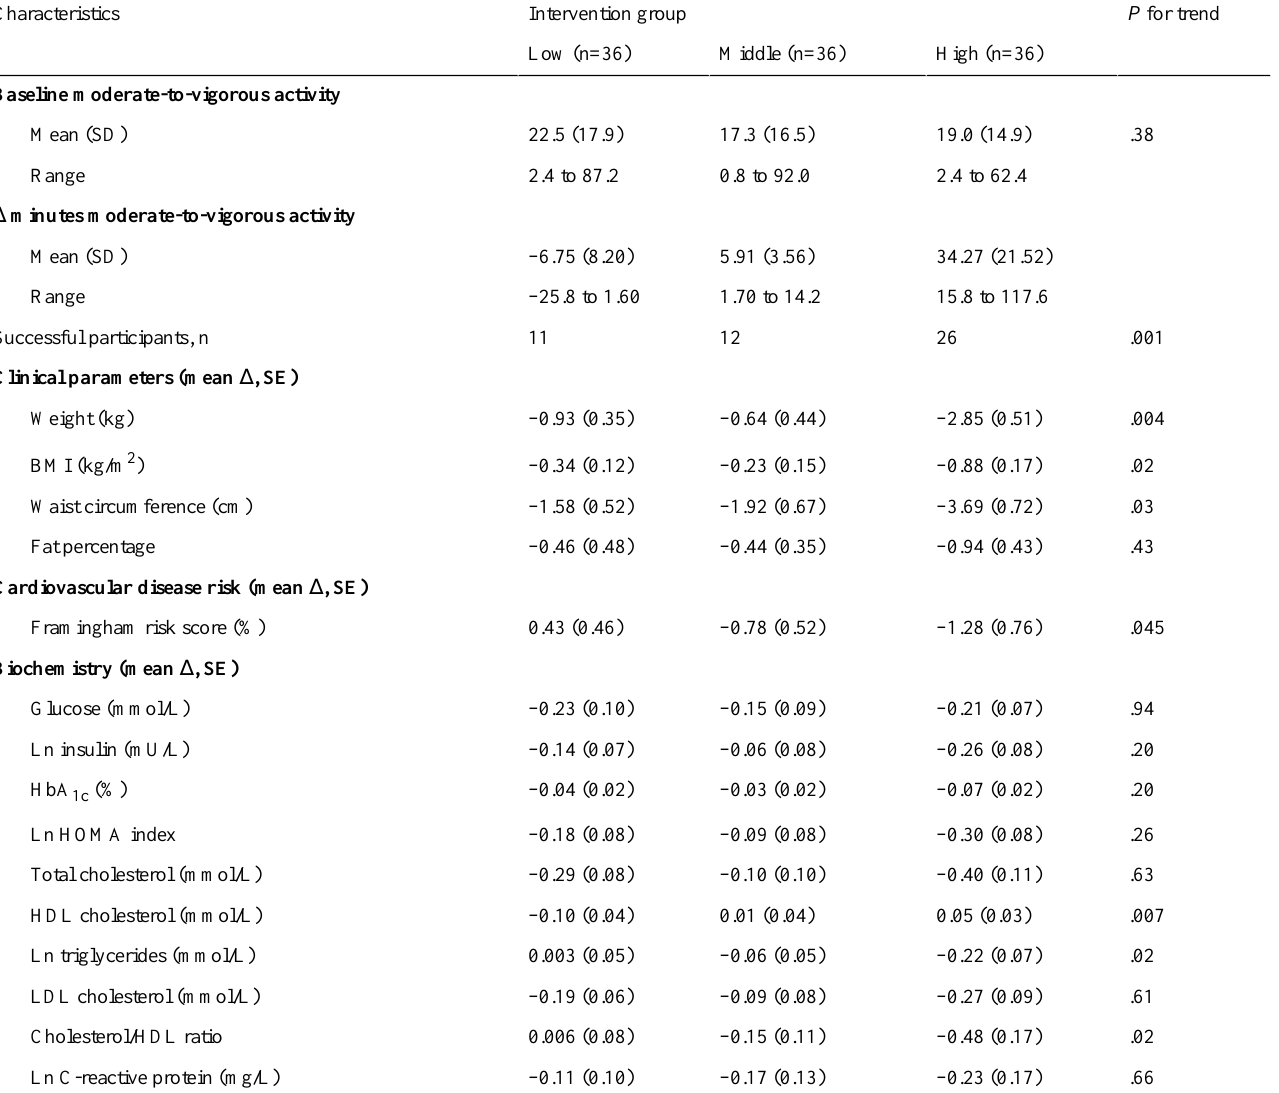
P for trendIntervention